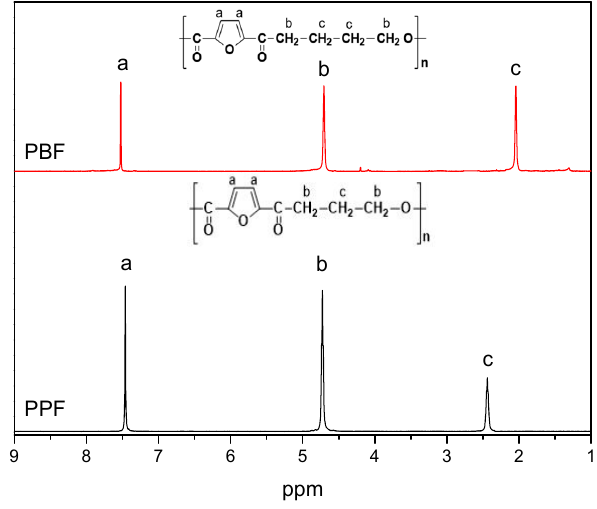
Figure 1. 1 H NMR of the prepared polyesters.